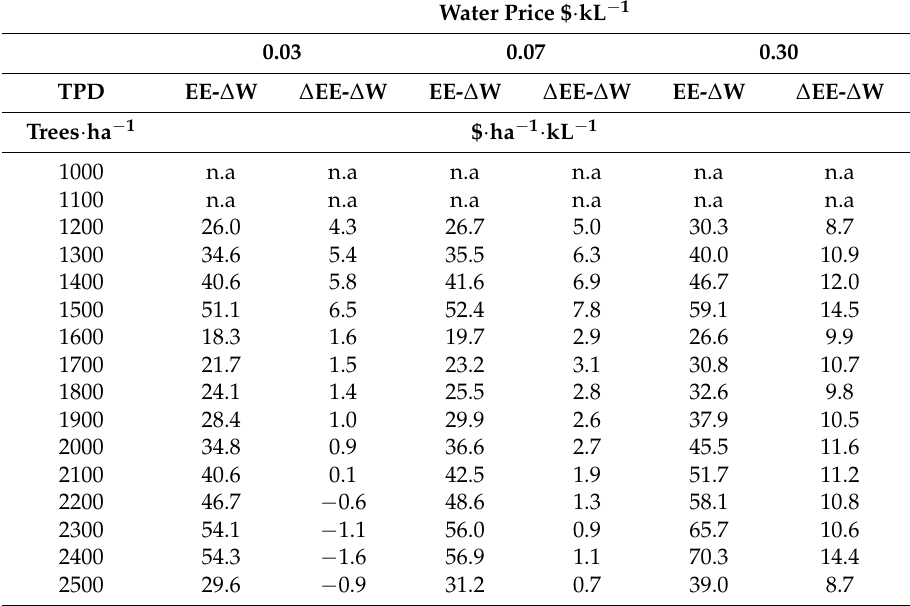
Table 3. Economic efficiency of increased water yield (EE- ∆ W, ∆ EE- ∆ W) for slash pine thinning